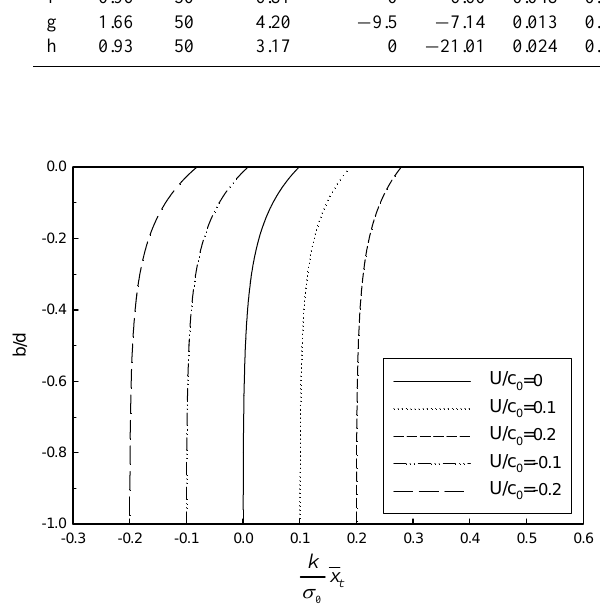
Fig. 3. The relative ratio for water particle motion at the free surface Figure 3. The relative ratio for water particle motion at the free surface between between Lagrangian and Eulerian periods for three current condi- at the c 0 Lagrangian and Eulerian periods for three current conditions.